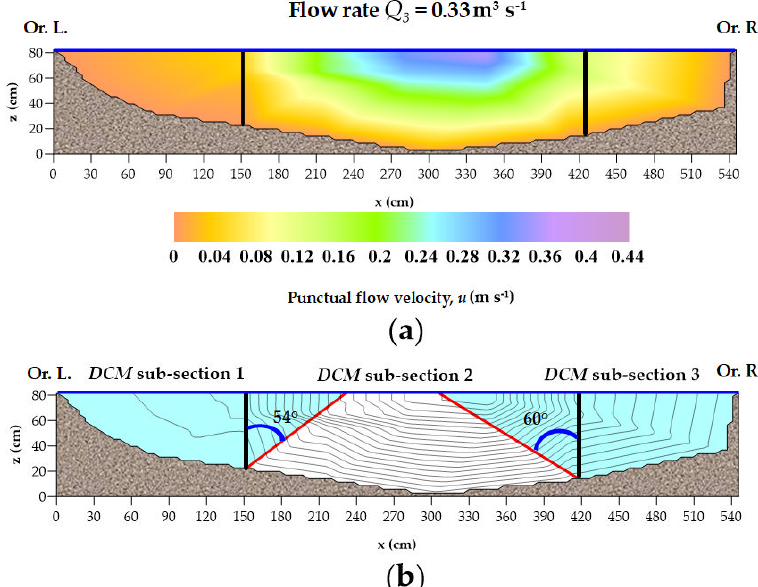
Figure 8. ( a ) Flow velocity field u (m · s − 1 ) for the Q 3 ( = 0.33 m 3 · s − 1 ) flow rate regime; ( b ) DCM sub- sections. The continuous dark blue line indicates the water level at bankfull. The continuous vertical black lines indicate the boundary of the side buffers of undisturbed riparian vegetation, while the red lines represent the borders of the DCM sub-sections, in which slopes were equal to 54° and 60°, respectively referred to DCM sub-section 1 and DCM sub-section 3 (light blue regions in Figure 8b). The side buffers of undisturbed riparian vegetation notably influenced the cross sectional flow velocity distribution for both Q 2 and Q 3 flow rate regimes, concentrating the water flow in the central region, cleared from vegetation, as depicted in Figures 7a and 8a. This phenomenon generates strong flow velocity gradients at the physical interface between the riparian vegetation buffers and the water flow [1] (continuous vertical black lines in Figures 7b and 8b) and affects significantly the slope of the boundary lines of the three DCM sub-sections: DCM sub-section 1, DCM sub-section 2 and DCM sub- section 3 (continuous vertical red lines in Figures 7b and 8b). The Q 2 and Q 3 flow rate regimes were characterized by a turbulent water flow regime, since the Reynolds numbers Re (= U·h/ ν , where U (m·s − 1 ) is the average flow velocity, h (m) is the water level at bankfull, and ν (m 2 ·s − 1 ) is the kinematic viscosity of water, equal to approximately 10 − 6 m 2 ·s − 1 ) referred to these flow rates were respectively equal to 4.1 × 10 4 and 8.3 × 10 4 . These values refer to the original values of hydraulic radius R , but they can be considered acceptable also for the condition of partial riparian vegetation cover, since the new values of R , referred to DCM sub-section 2 in which the flow motion was essentially concentrated, are similar to the original ones. 3.1.3. Bp and S&S Combined with Composite Cross Section Methods The input parameters of the formulas of the four composite cross section methods examined in the present study [12 – 15], for each of the three DCM sub-sections described in the previous Section 3.1.2, are summarized in the following Tables 2 and 3, respectively referred to the two analyzed flow